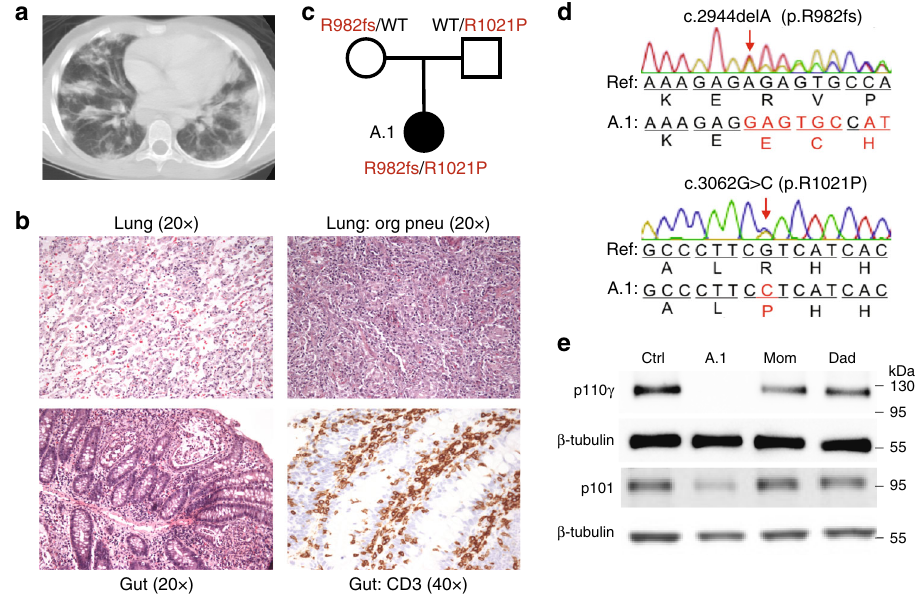
Fig. 1 Patient with loss of PI3K γ and T lymphocytic in fi ltration of lung and gut. a Chest computed tomography scan with diffuse pulmonary nodular and patchy in fi ltrates. b Hematoxylin and eosin staining of histological sections of a lung biopsy with lymphocytic in fi ltrates (top left) and regions of organizing pneumonia (top right) and gut biopsy with lymphocytic in fi ltrates (bottom left) and staining for CD3 (bottom right). c Pedigree with PIK3CG alleles inherited by patient A.1. d Chromatograms obtained by Sanger sequencing of PIK3CG genomic DNA from patient A.1. e Immunoblotting of p110 γ , p101, and β -tubulin in T cell blasts from an unrelated healthy control, patient A.1, and parents